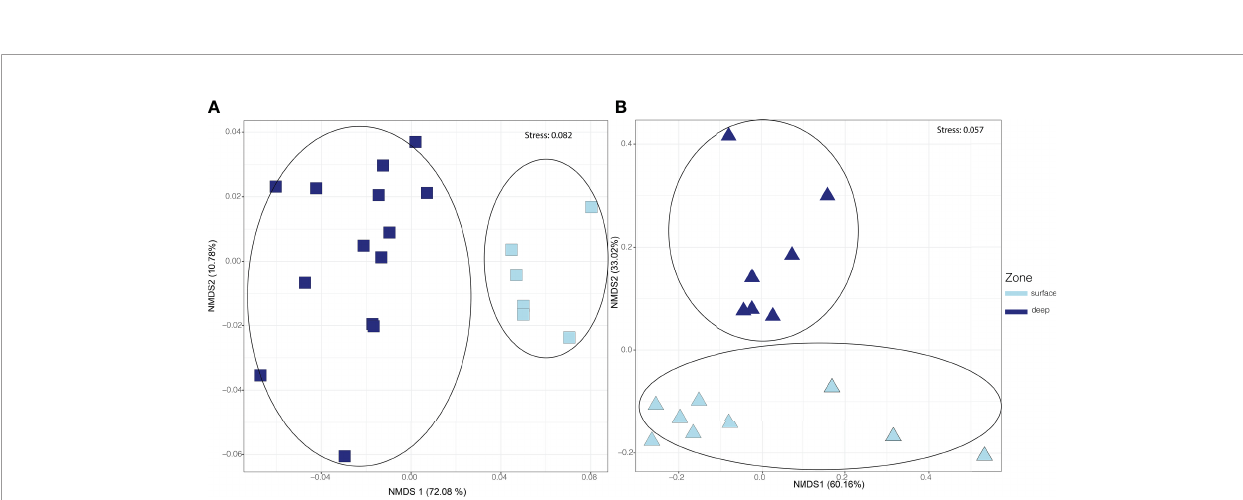
FIGURE 4 | Distribution of microbial potential and expressed pathways in the surface waters (0-150 m) versus deep waters (250-4000 m). NMDS ordinations are based on RPKM abundances of metagenomic pathways and metatranscriptomic pathways. In all panels, depth “ zone ” is indicated by colour, and shape represents dataset type (metagenomic pathways in squares & metatranscriptomic pathways in triangles). (A) NMDS ordination of metagenomic pathway abundances, with a signi fi cant distribution of metagenomic pathways according to depth (ANOSIM, p< 0.05, R=0.79). More depths were sampled for metagenomic data than for metatranscriptomic data, thus resulting in more data points shown here. (B) NMDS ordination of metatranscriptomic pathway abundances showing signi fi cantly distinct metatranscriptomic pathway groupings according to an ANOSIM test (p < 0.05, R=0.44), demonstrated by the encircled